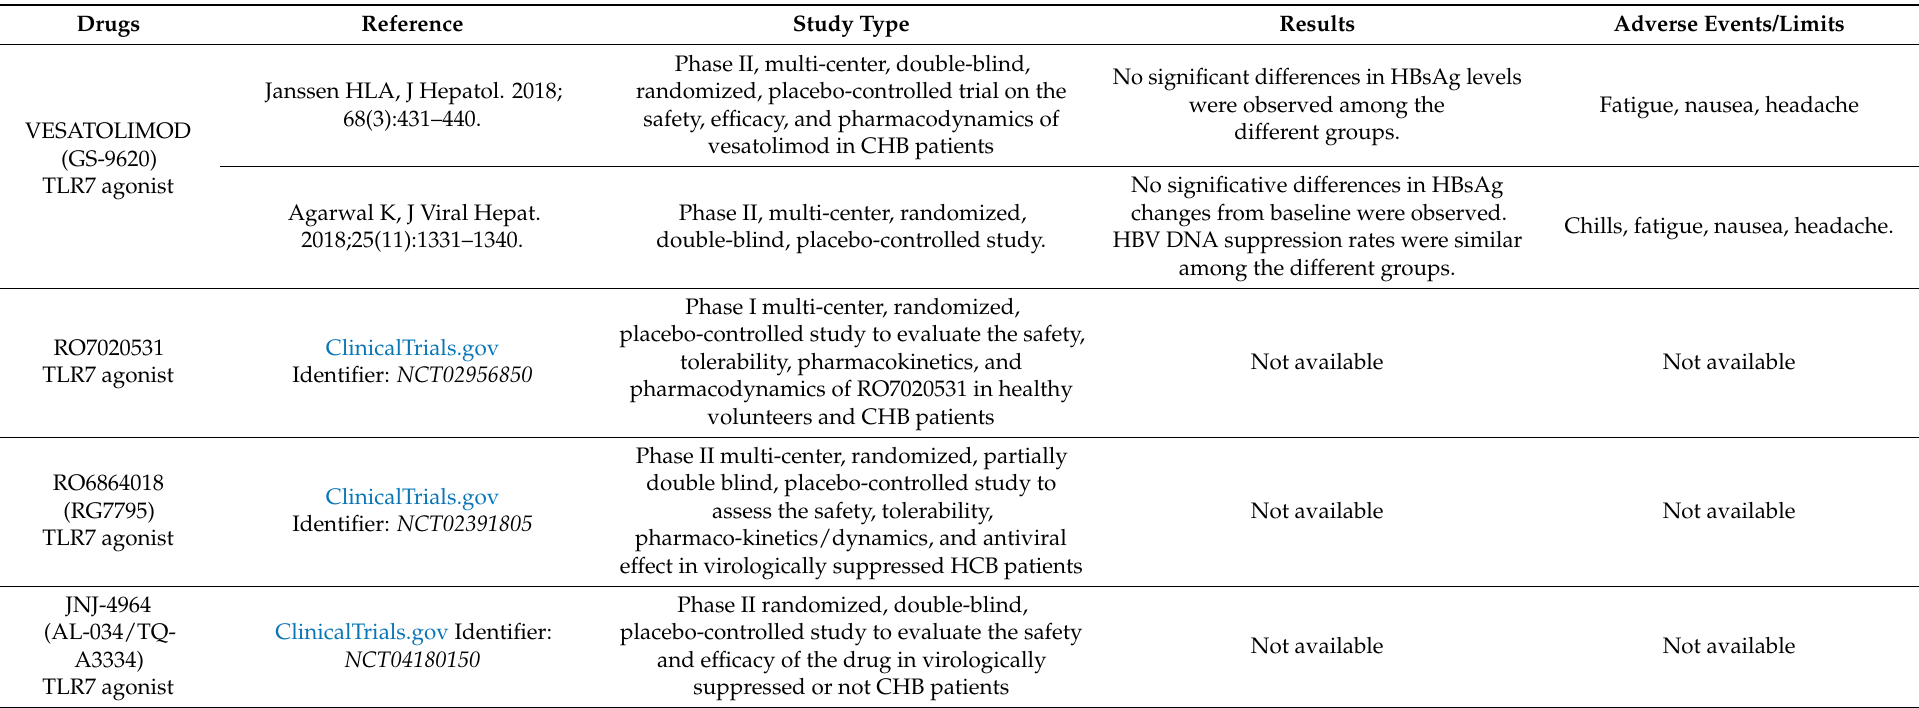
Table 2. Some of the main immunomodulatory drugs under investigation in the HBV chronic infection field. TLR: toll-like receptor; CHB: chronic hepatitis B; ISG15: interferon